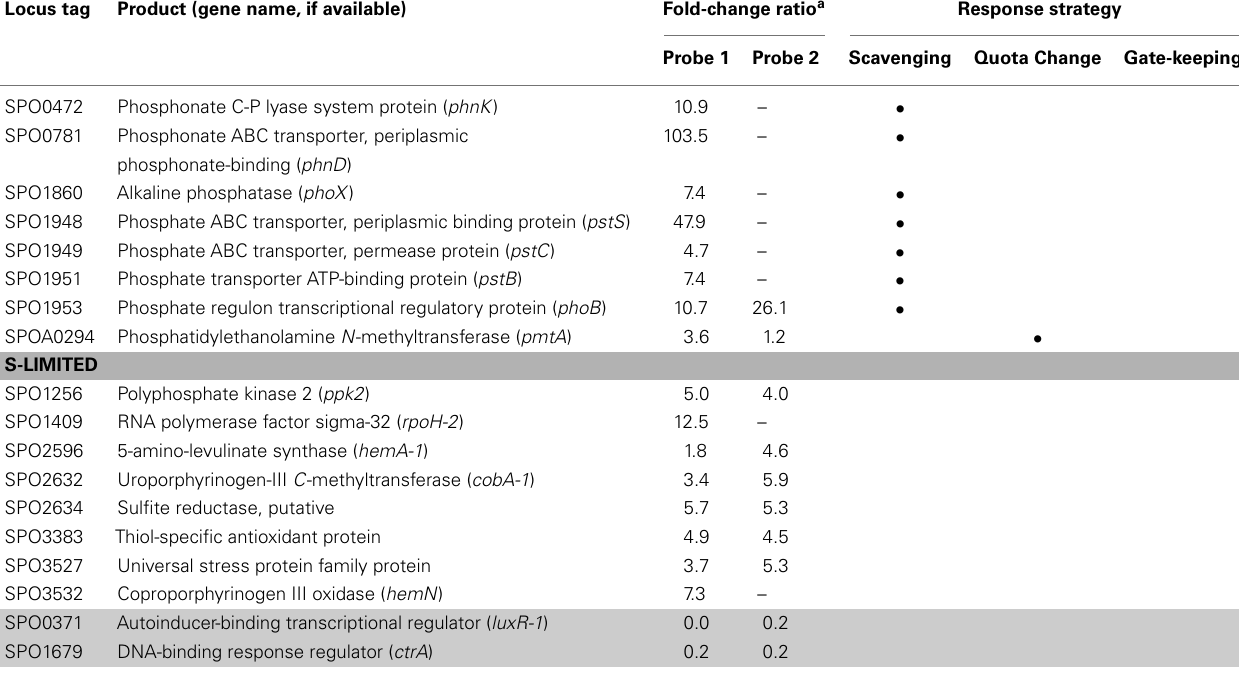
( Table 2 ; Figure A4 in Appendix) may all be linked to a depleted pool of S -adenosyl-methionine ( Figure A4 in Appendix). Evi- dence for a cellular stress response was strongest under S limi- tation, and this included enrichment of transcripts for a thiol-